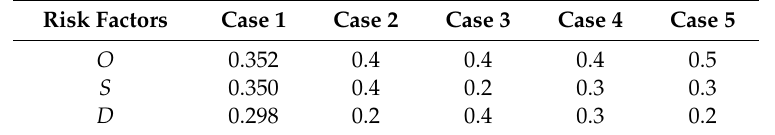
Table 9. Risk factor weights in sensitivity analysis.